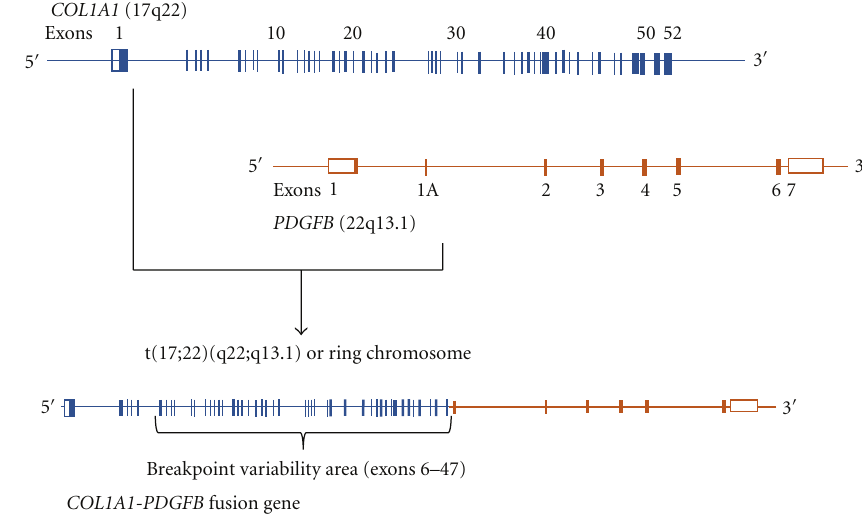
Figure 1: Schematic presentation of the COL1A1/PDGFB fusion gene formation.